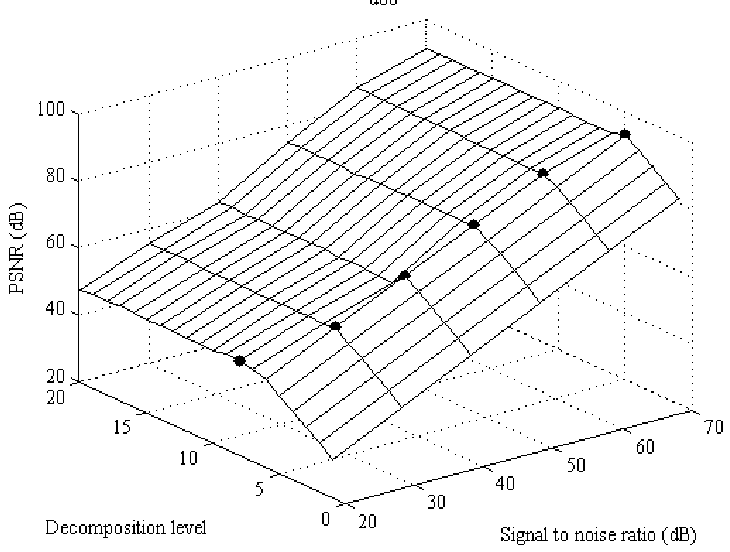
Figure 8. Noise reduction for db6 as a function of decomposition level and SNR.